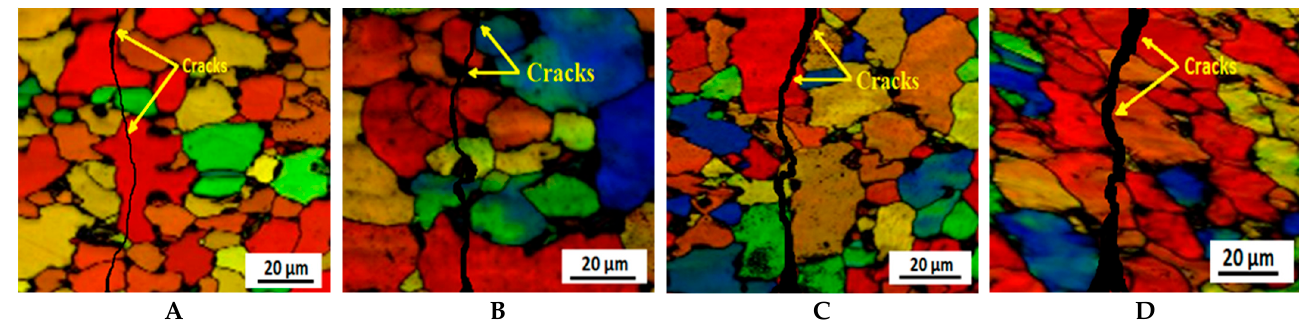
Figure 9. EBSD orientation micrograph of Al5083 alloy in air for ( A ) the as-received sample and samples after the ( B ) 1st pass, ( C ) 2nd pass, and ( D ) 3rd pass.